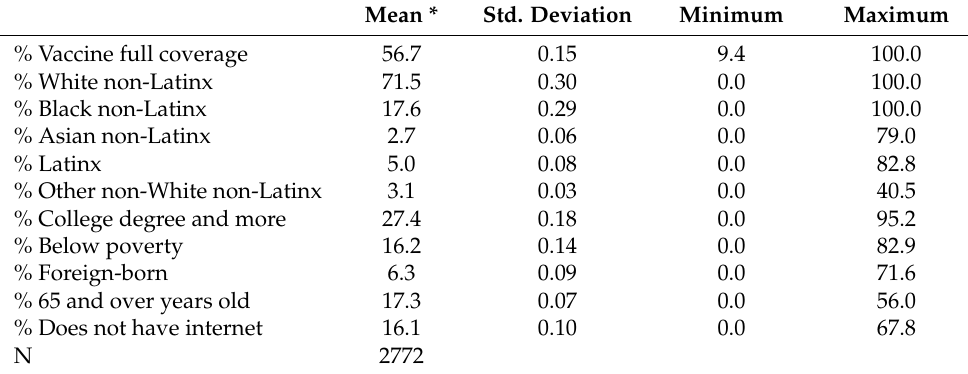
Table 1. Descriptive summary of variables. Mean * Std. Deviation Minimum